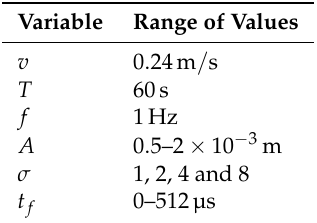
Table 2. Values of the model parameters used in the